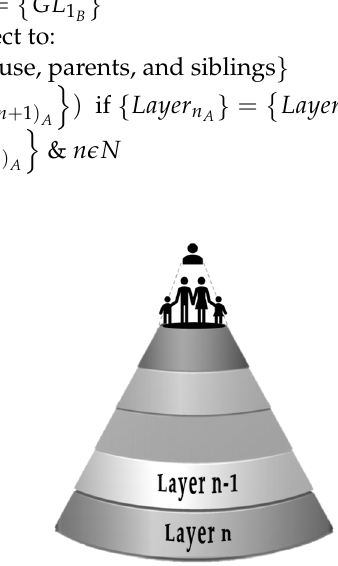
Figure 6. A 3D presentation of the model.